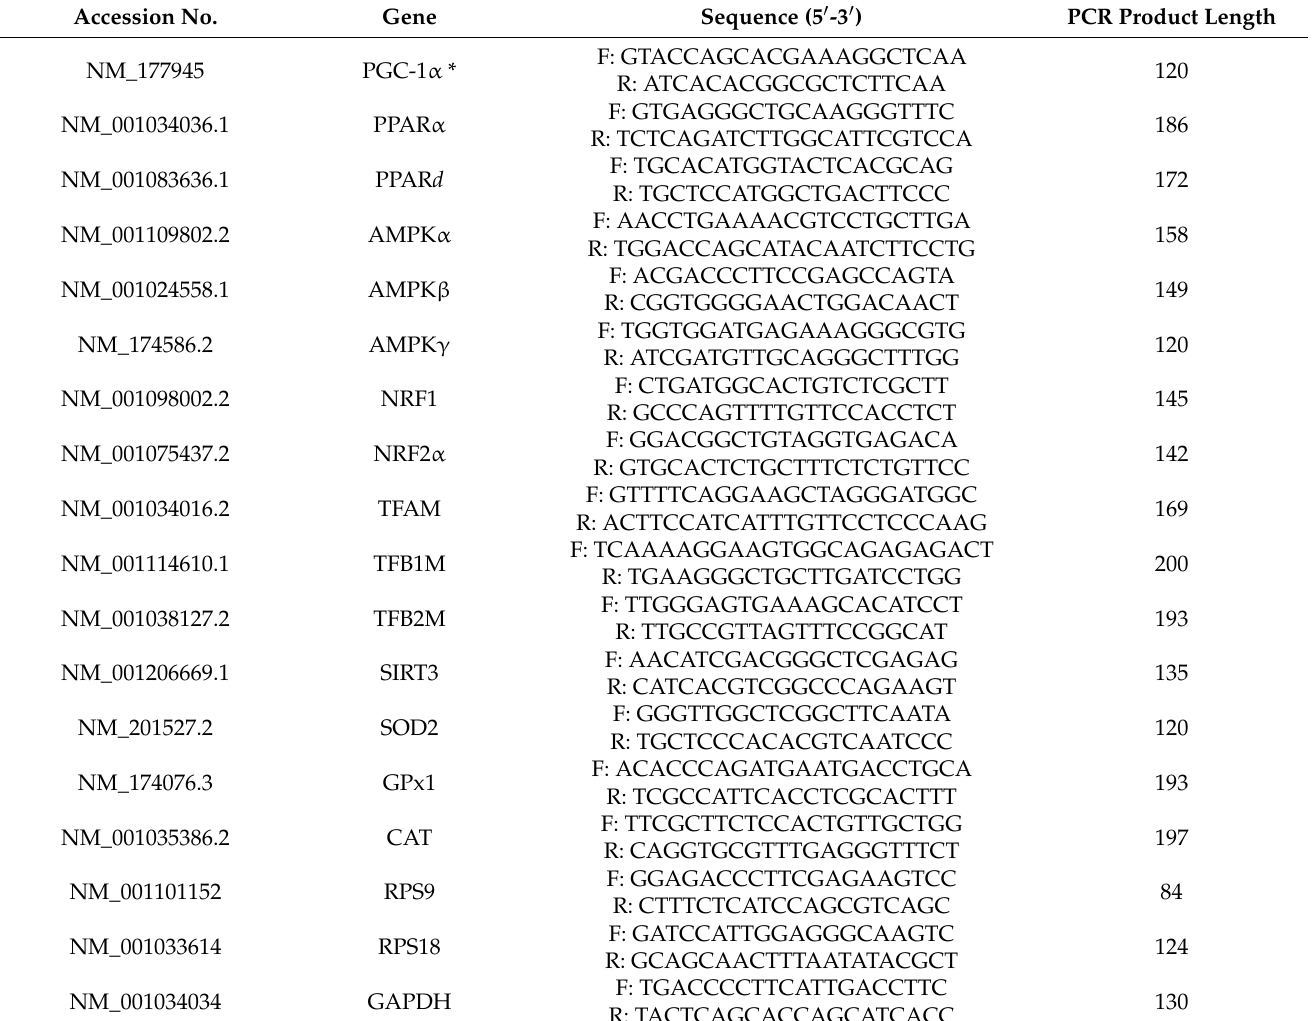
Table 1. Primer information for qRT-PCR